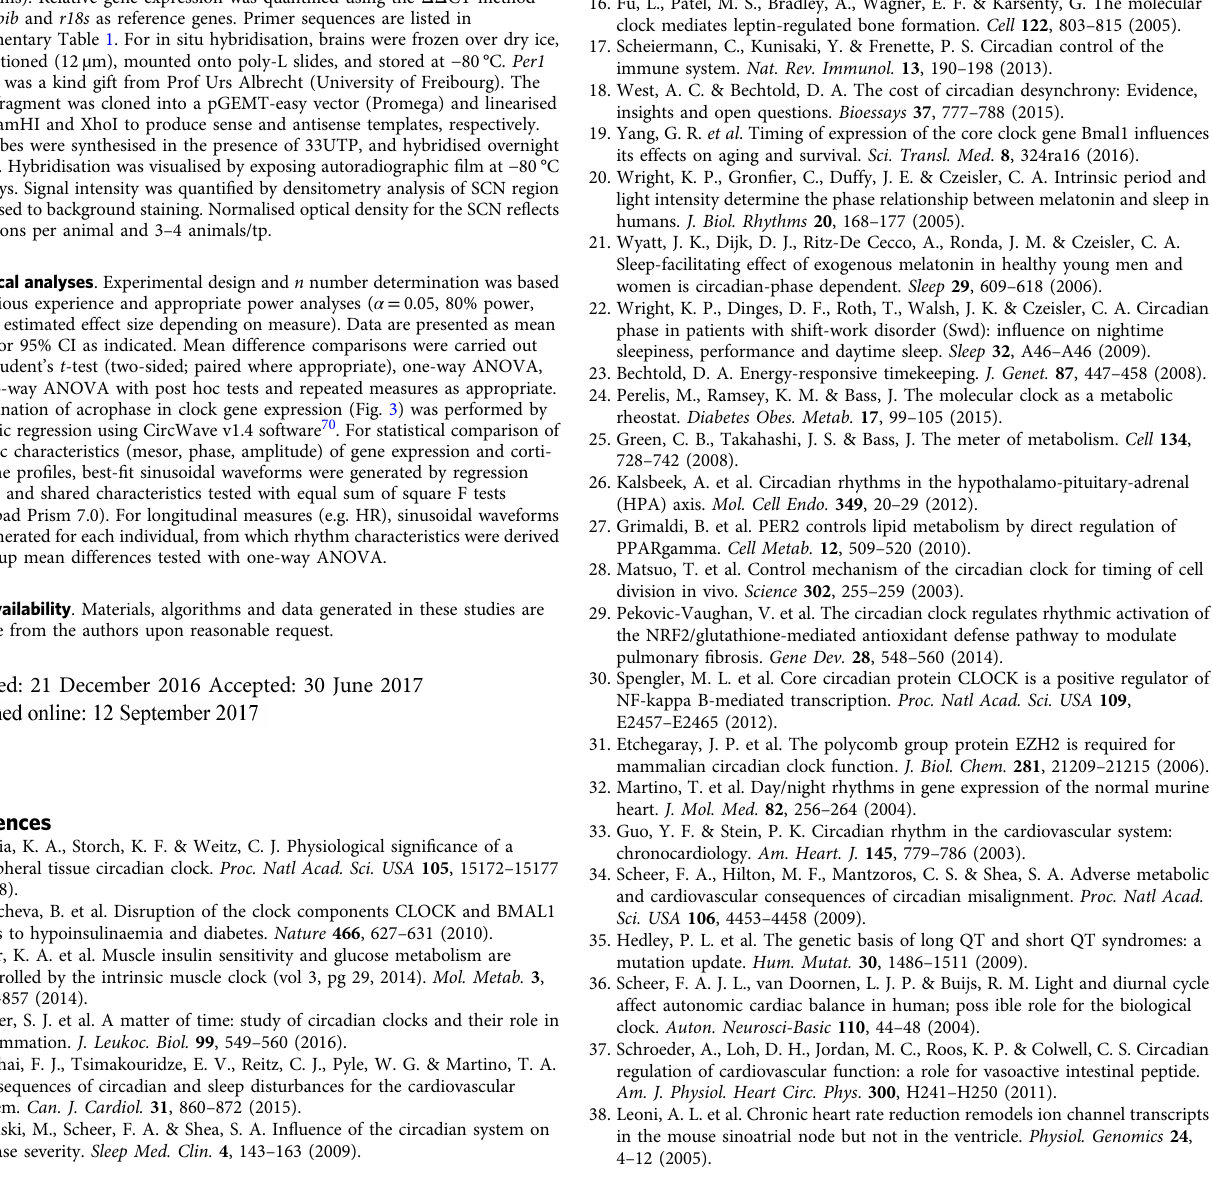
Supplementary Table 1. For in situ hybridisation, brains were frozen over dry ice, cryo-sectioned (12 µ m), mounted onto poly-L slides, and stored at − 80°C. Per1 plasmid was a kind gift from Prof Urs Albrecht (University of Freibourg). The cDNA fragment was cloned into a pGEMT-easy vector (Promega) and linearised using BamHI and XhoI to produce sense and antisense templates, respectively. Riboprobes were synthesised in the presence of 33UTP, and hybridised overnight at 60°C. Hybridisation was visualised by exposing autoradiographic fi lm at − 80 °C for 7 days. Signal intensity was quanti fi ed by densitometry analysis of SCN region normalised to background staining. Normalised optical density for the SCN re fl ects > 3 sections per animal and 3 – 4 animals/tp. Statistical analyses . Experimental design and n number determination was based on previous experience and appropriate power analyses ( α = 0.05, 80% power, 20 – 50% estimated effect size depending on measure). Data are presented as mean ± SEM or 95% CI as indicated. Mean difference comparisons were carried out using Student ’ s t -test (two-sided; paired where appropriate), one-way ANOVA, and two-way ANOVA with post hoc tests and repeated measures as appropriate. Determination of acrophase in clock gene expression (Fig. 3) was performed by harmonic regression using CircWave v1.4 software 70 . For statistical comparison of rhythmic characteristics (mesor, phase, amplitude) of gene expression and corti- costerone pro fi les, best- fi t sinusoidal waveforms were generated by regression analyses and shared characteristics tested with equal sum of square F tests (Graphpad Prism 7.0). For longitudinal measures (e.g. HR), sinusoidal waveforms were generated for each individual, from which rhythm characteristics were derived and group mean differences tested with one-way ANOVA. Data availability . Materials, algorithms and data generated in these studies are available from the authors upon reasonable